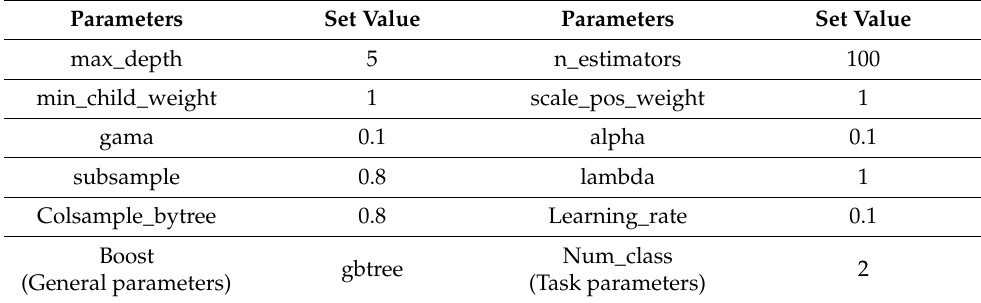
Table 2. Parameter configuration table.